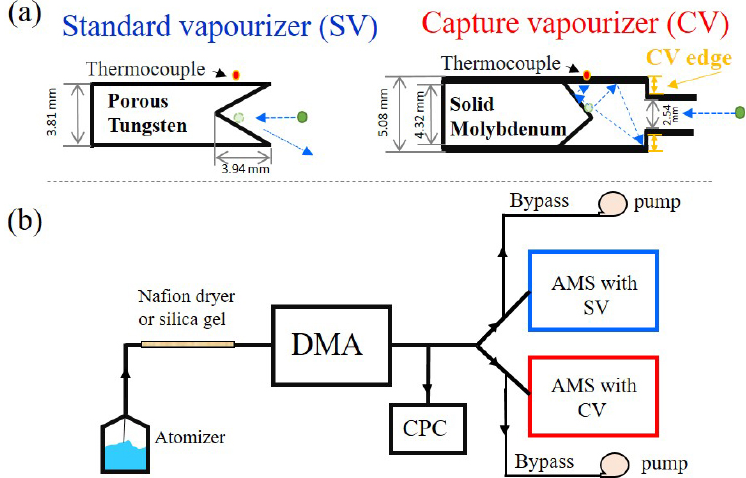
Figure 1. (a) Schematic diagrams of the standard vapourizer (SV) and capture vapourizer (CV). More details of the CV design can be found in Xu et al. (2017). The appearance of the SV and CV are shown in Fig. S1. (b) Set up of laboratory experiments for comparing the SV and CV. The sampling gas was kept below 30% RH by Nafion dryers and/or silica gel diffusion